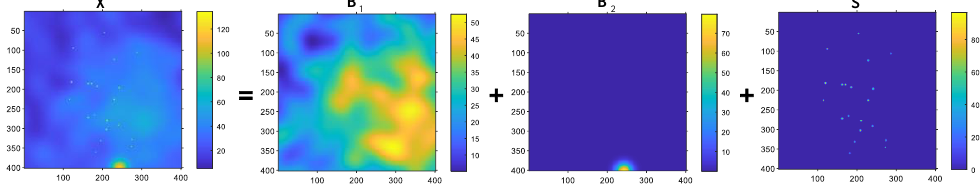
Figure 2. The simulation data with two smooth layers, sparse spots layer, and a noise layer and the scree plot of the simulation data.